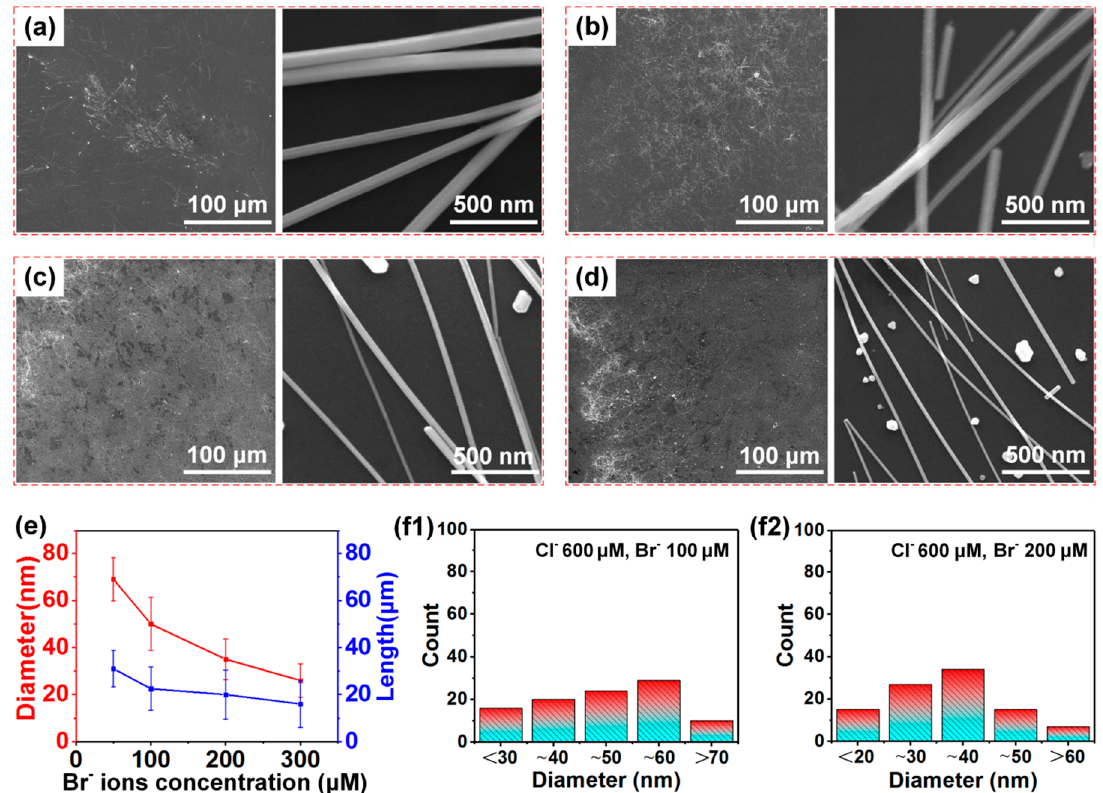
Figure 3. SEM images of products synthesized with 600 µM of NaCl and different additions of NaBr, which are ( a ) 50 µM, ( b ) 100 µM, ( c ) 200 µM, and ( d ) 300 µM, respectively. Changes in AgNW diameter and length with Br − ion concentration are summarized in ( e ). The histograms of AgNW diameter are shown in ( f1 ) and ( f2 ) at 100 µM and 200 µM Br − concentration, respectively.